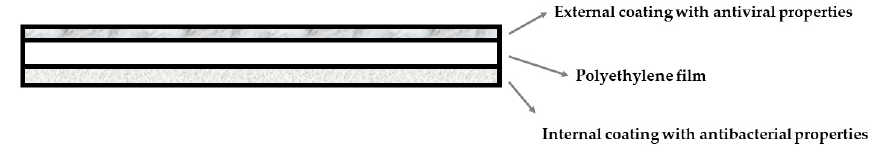
Figure 8. Multilayer active polyethylene packaging.